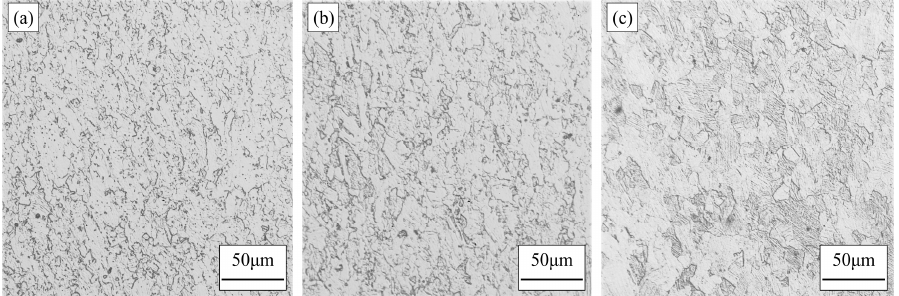
Figure 6. Optical Microstructures of FeMnSiCrNi SMA undergoing compression (